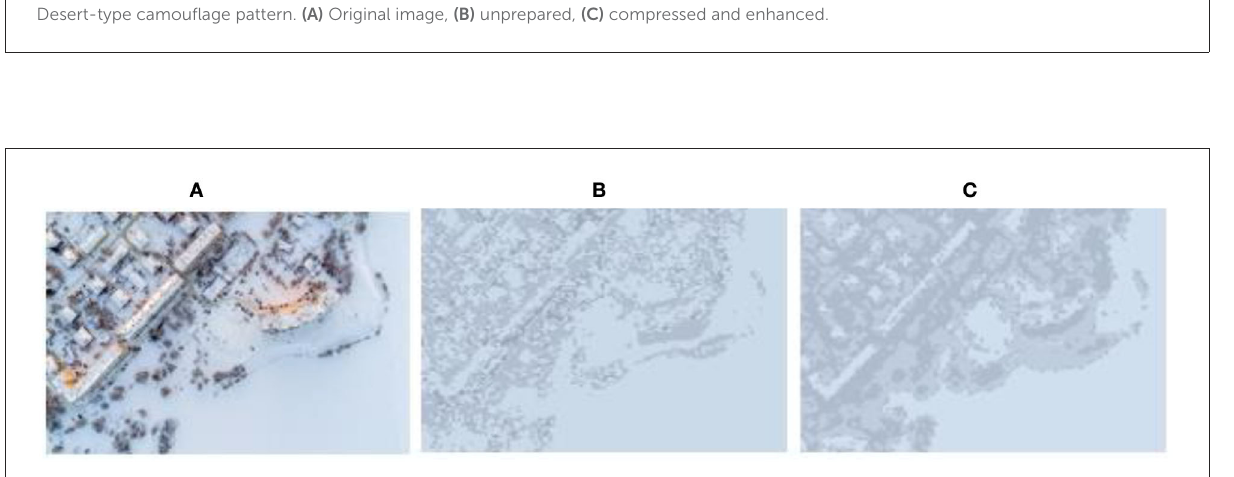
FIGURE13 Snow-type camouflage pattern. (A) Original image, (B) unprepared, (C) compressed and enhanced.